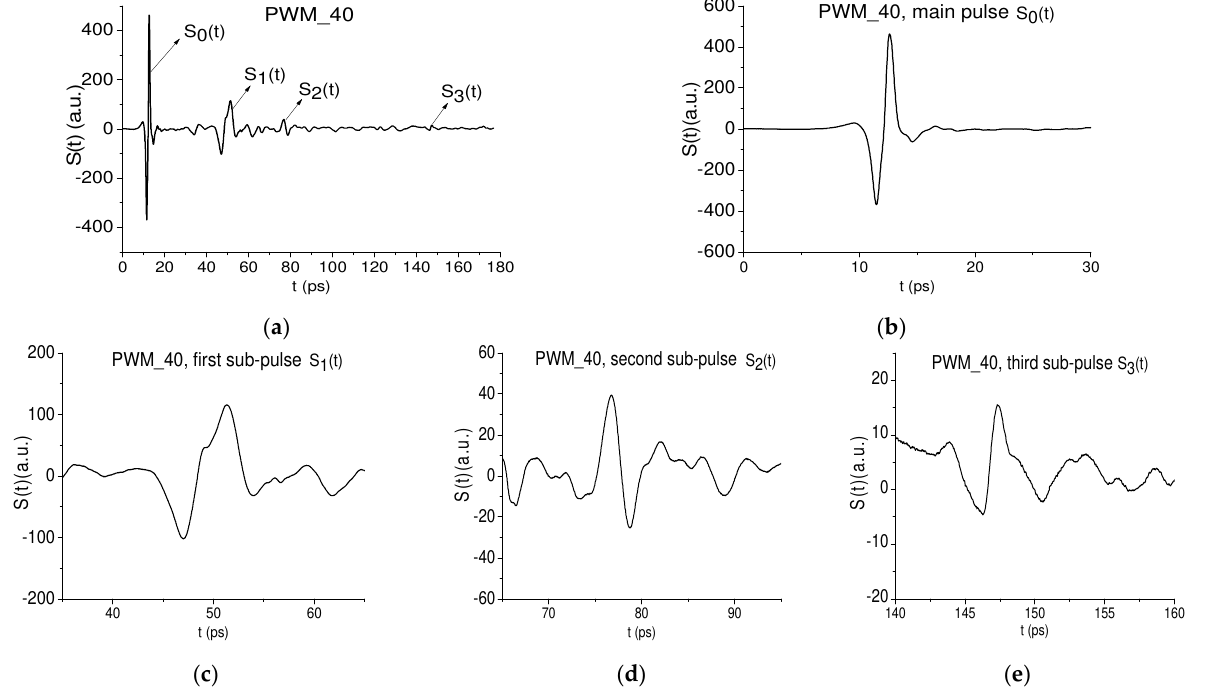
Figure 9. THz signal PWM_40 reflected from the rough surface and depicted in the time intervals t = [0, 180] ps ( a ), t = [0, 30] ps ( b ), [35, 65] ps ( c ), [65, 95] ps ( d ), and [140, 160] ps ( e ). It is worth noting that the sub-pulses same phase as the main pulse Figure 9d demonstrates the inversion of its phase in comparison with the main pulse ( ) S t 0